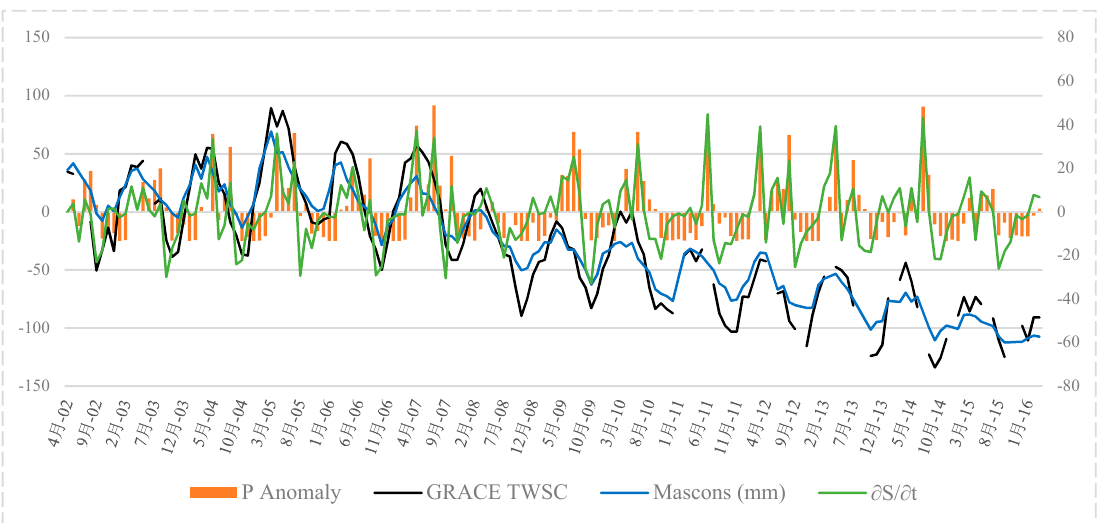
Figure 5. Comparison of the TWSC resulting from the GRACE data for the water budget and precipitation anomalies.